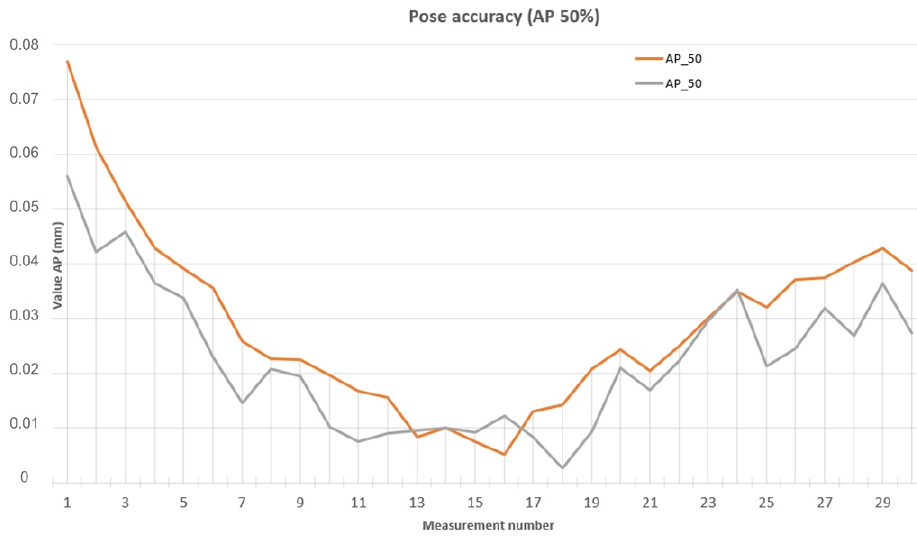
Figure 5. Plotted comparison of AP under half the load.